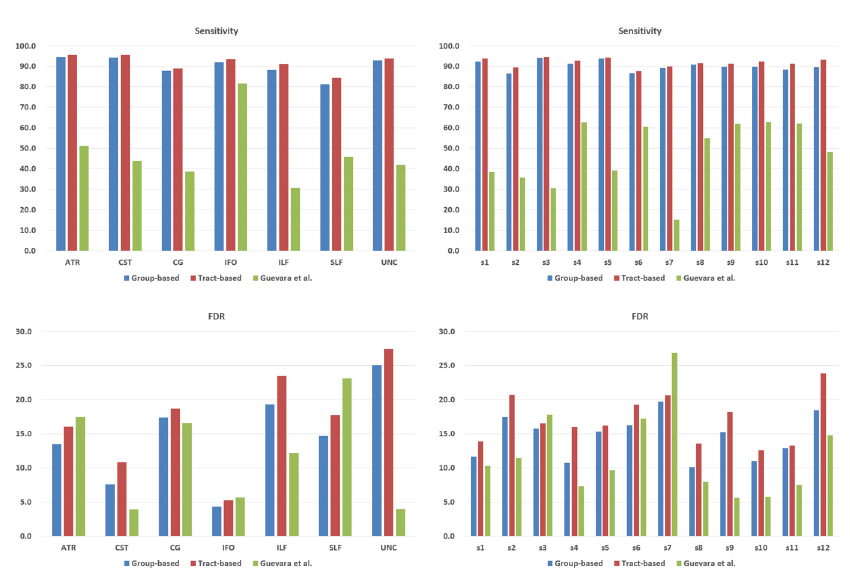
Fig 8. Sensitivity and FDR histograms for tract group labeling, direct tract labeling, and Guevara ’ s method. Top left: sensitivities of the three methods for each anatomic bundle, Top right: sensitivities of the three methods for each example subject. Bottom left: FDRs of the three methods for each anatomic bundle, Bottom right: FDRs of the three methods for each example subject.